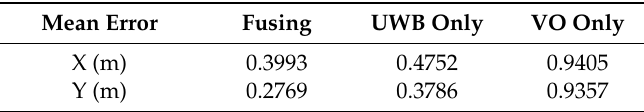
Table 4. Mean error of three positioning